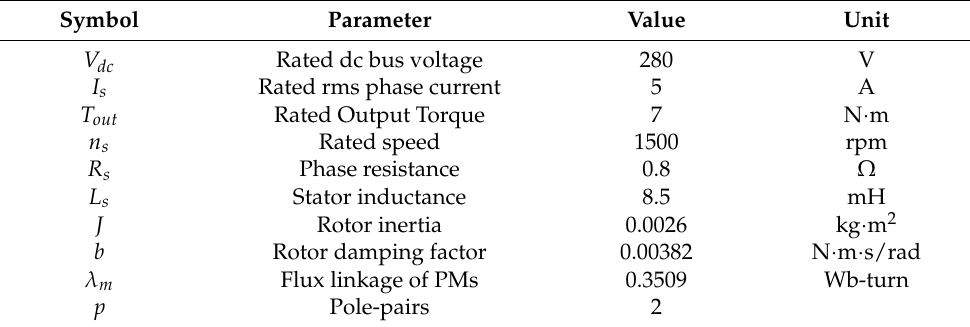
Figure 9. Experimental Setup for control and diagnosis of a PMSM. Table 1. Parameters of a PM synchronous